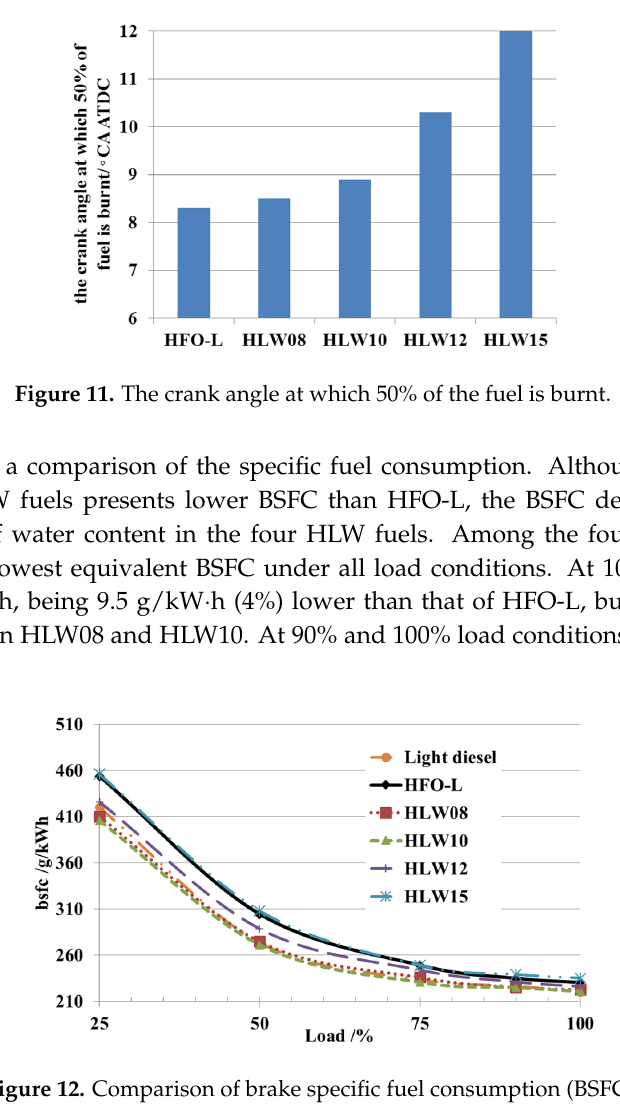
Figure 10. Comparison of the heat release rate curves of the cases fueled with four fuel blends.